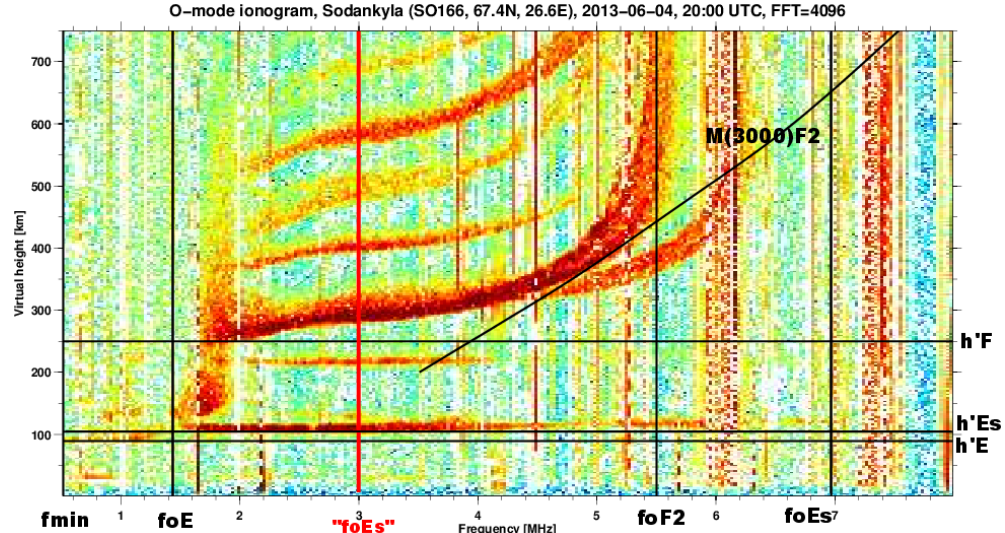
Figure 8. Differences between manual and Autoscala scaling arising from high latitude sporadic E phenomena. Black lines show manually scaled parameters, and red colour (lines and/or letter) indicates Autoscala results. Example 3: Underestimated foE s (3.0MHz vs. manual 7.0MHz)